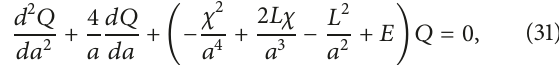
Figure 3: The effective potential 𝑉 𝑠𝑝ℎ (𝑎) in the radial part of the Schr¨odinger equation in spherical coordinates, Eq. (26). Solid lines represent 𝑐 = 0 potentials, and dotted lines represent 𝑐 = 5 potentials, for the same 𝐿, 𝜒